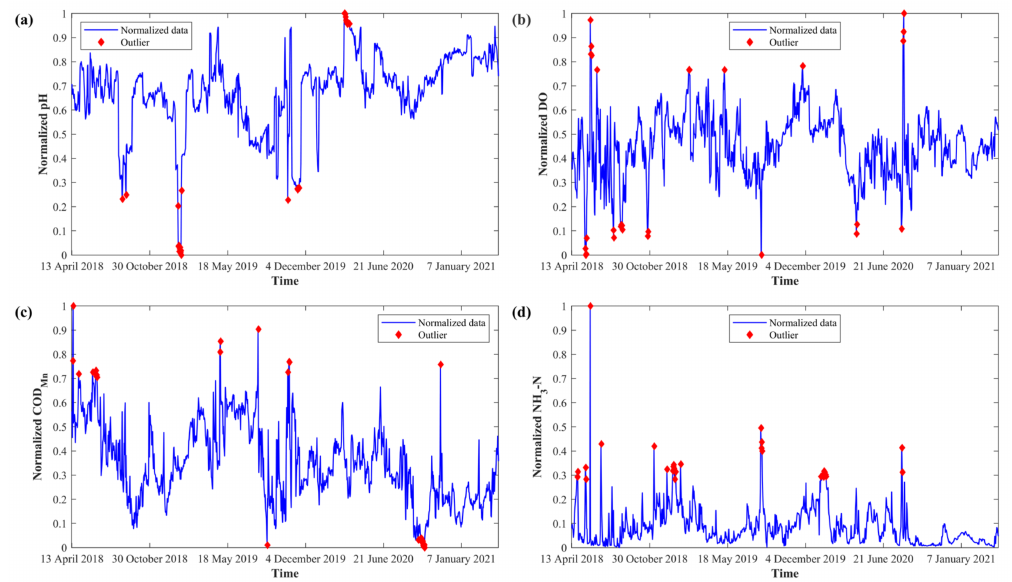
Figure 5. The outlier detection results of ( a ) pH, ( b ) DO, ( c ) COD Mn , and ( d ) NH 3